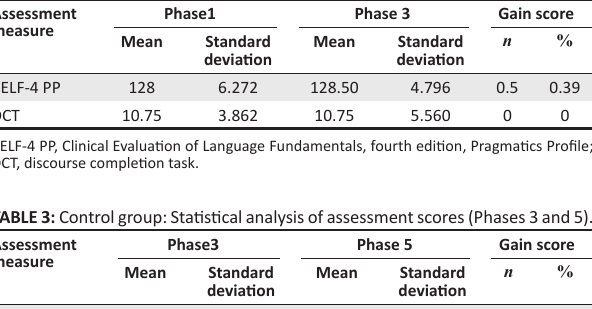
TABLE 2: Control group: Statistical analysis of assessment scores (Phases 1 and 3). Assessment measure